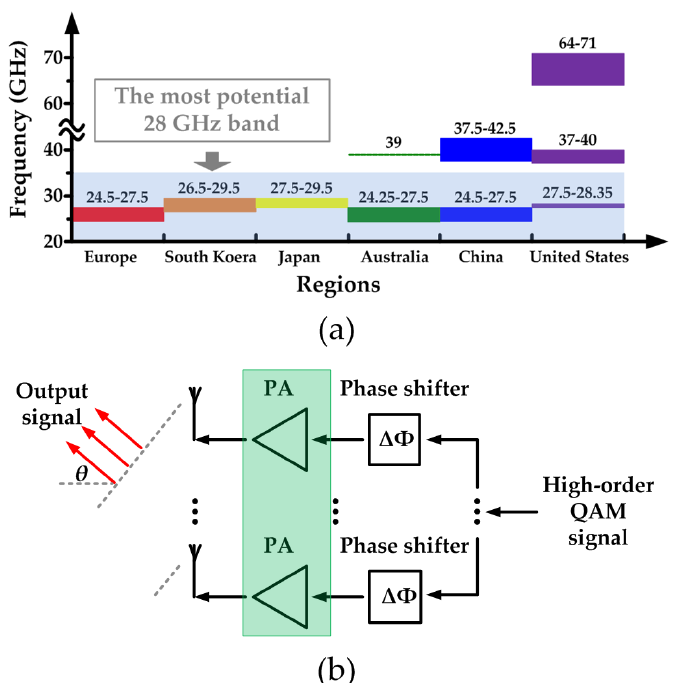
Figure 1. ( a ) Spectra for 5th generation (5G) applications proposed by different regions in the world, ( b ) an example of a transmitter frontend for 5G phased array.